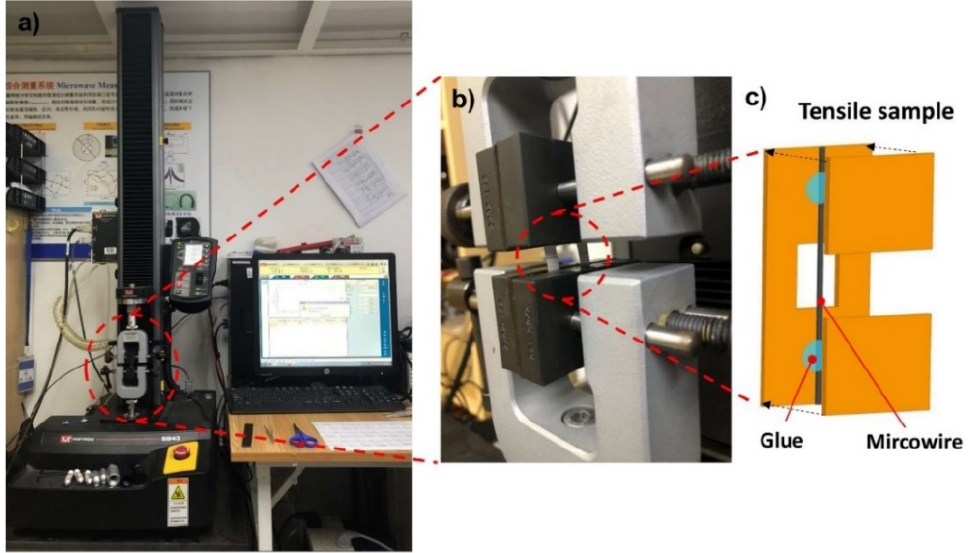
Figure 1. Microfiber tensile testing system: ( a ) Instron 5943 electronic universal materials testing machine; ( b ) Screw side-action grips; ( c ) Microfiber tensile sample. Table 1. The chemical composition of Co-based metallic microwires.